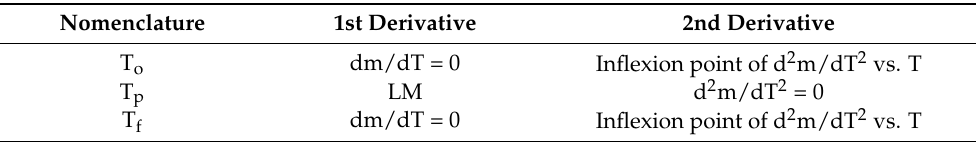
Table 2. Proposed determination protocol of onset (T o ), peak (T p ) and final (T f ) characteristic temperatures of thermal transitions employing TGA